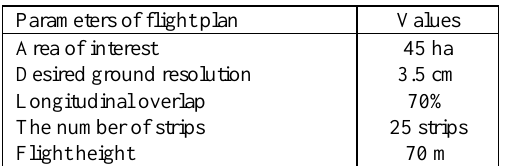
Table 1. The parameters of flight plan of Phantom-4 UAV that was used in this